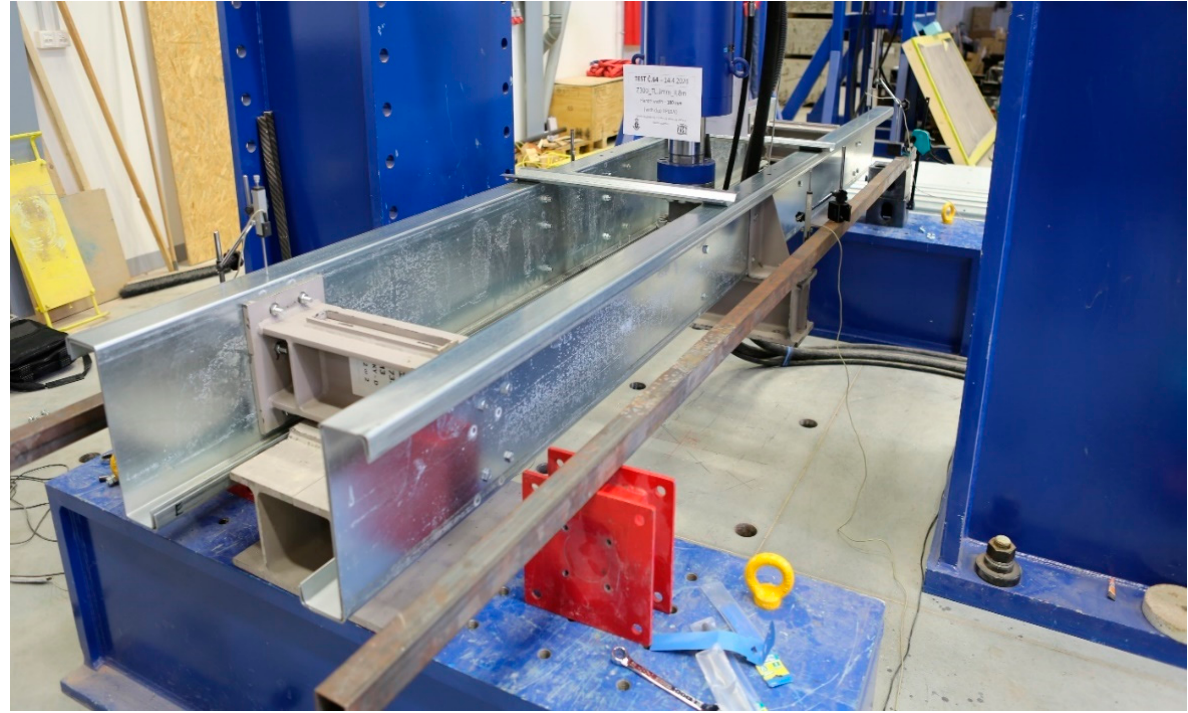
Figure 2. Load experiment of Z350 purlins at a span of 3.0